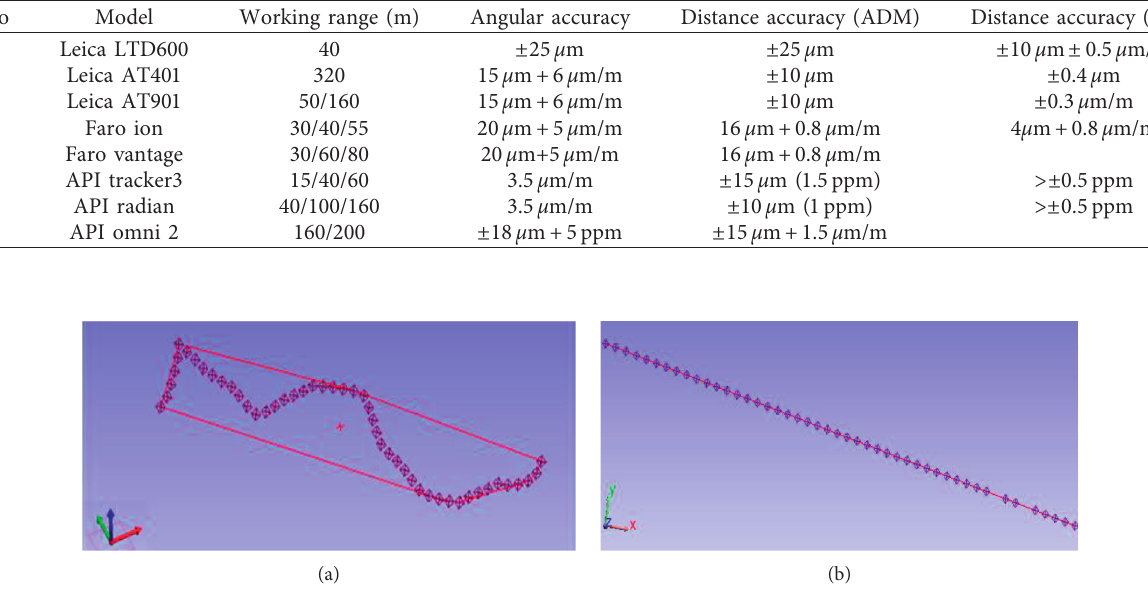
Table 2: Commercial laser tracer specifications [9].